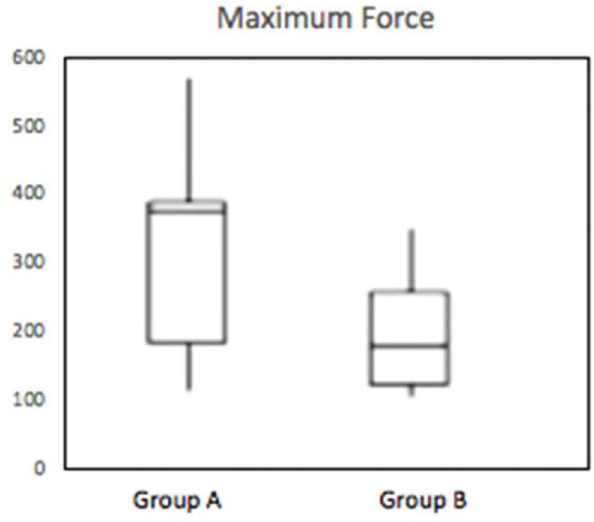
Figure 8 - Box-plot demonstrating the distribution of maximum elongation (mm) of groups A and B ( p =0.007). * Outlier.